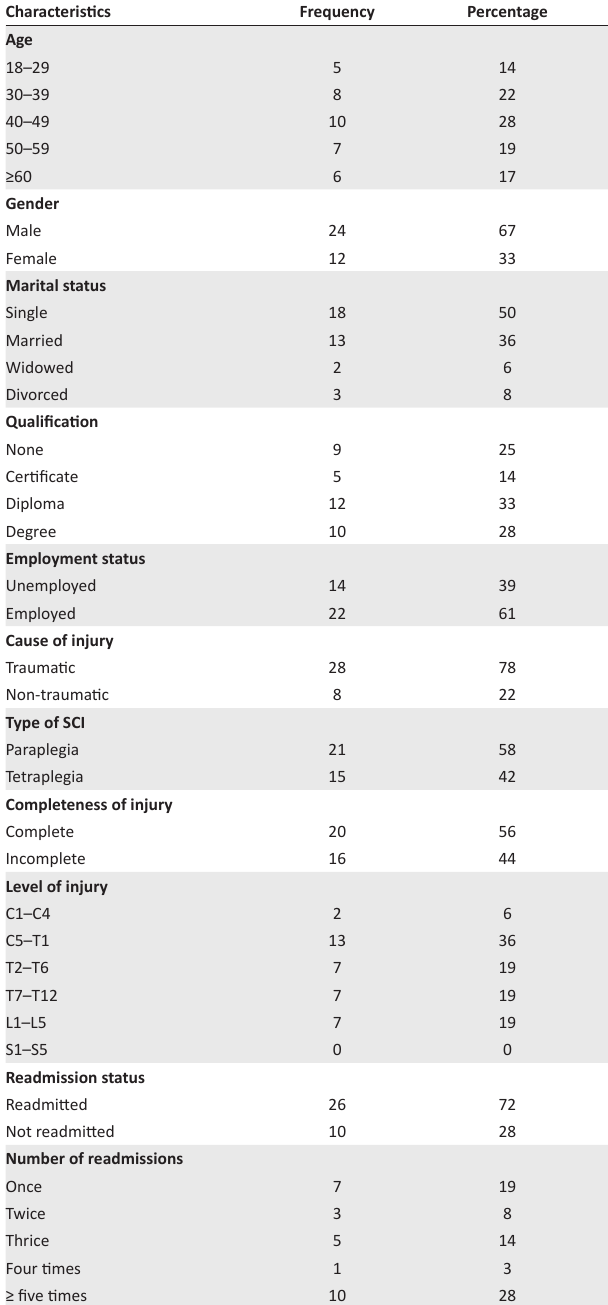
TABLE 1: Frequency distribution of demographic variables of participants ( n =